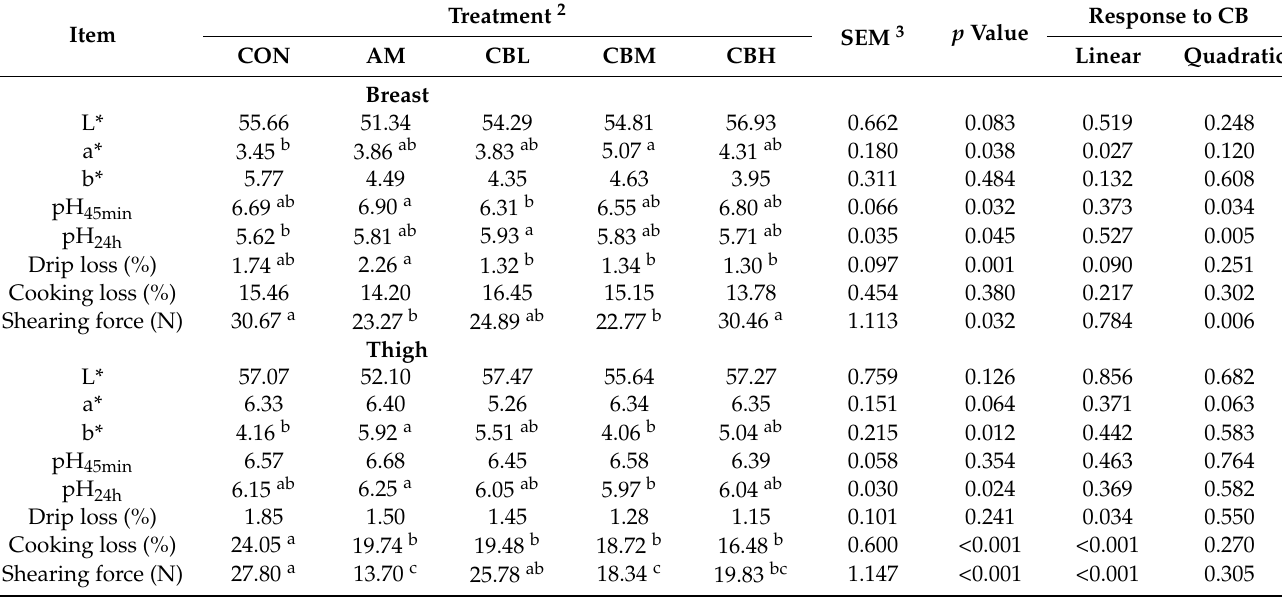
Table 4. Effects of C. butyricum on meat quality of broilers 1